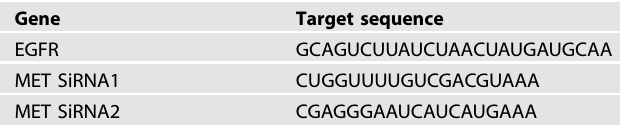
Fig. 7 Phosphorylation of EGFR/MET was related to high-energy phosphate compounds but not EGFR/MET hetero-dimer. A MET phosphorylation ratio was compared in different HCC cell. Co-immunoprecipitation was used for detection of crosstalk in ( B ) EGFR/p-EGFR or MET/p-MET after stimulation of ligand and ( C ) EGFR-EGFR, MET-MET and EGFR-MET in cells with MET ampli fi cation. D RTKs Phosphorylation Array was used for detection of phosphorylation of RTKs after incubation with 0.2 mM ATP in PLC/PRF/5 and MHCC97H cell lines. E Western Blot was used for detection of phosphorylation of EGFR/MET stimulated by ATP/GTP. 0.2 mM of ATP/GTP was incubated with cell lysate of PLC/ PRF/5 with kinase buffer for 1 h at 37 °C. F Phosphorylation of EGFR in PLC/PRF/5 cell lysis with 0.2 mM of ATP with creatine kinase or MET knock-down was detected by Western Blot. Table 2. Sequences of EGFR/MET